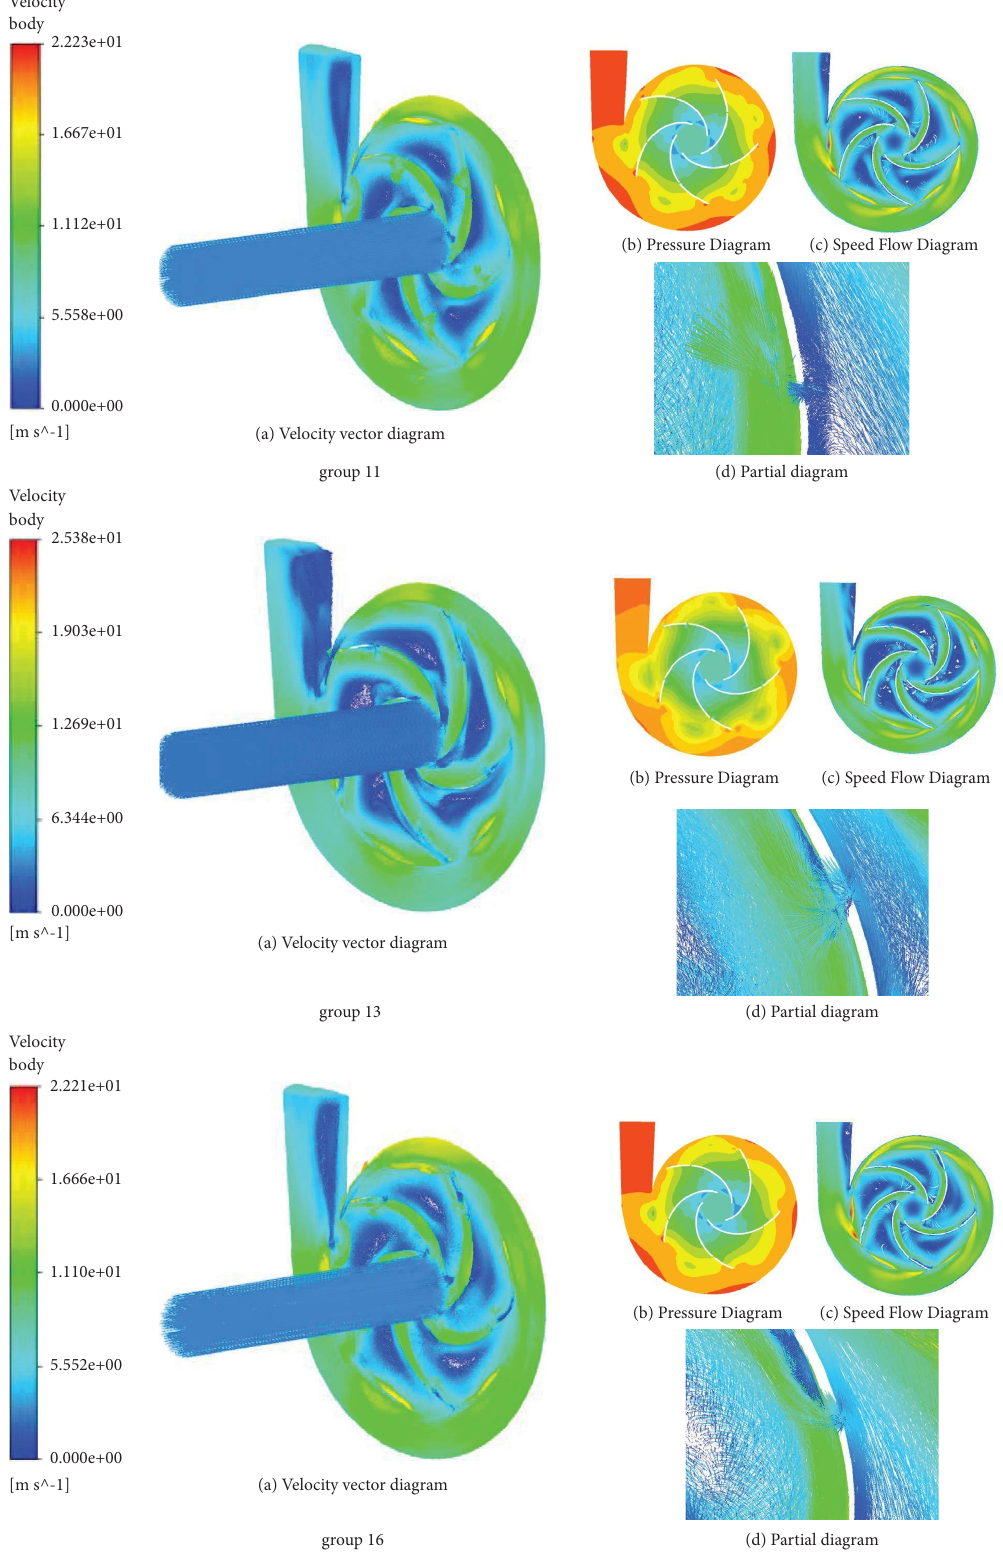
Figure 11: Flow feld diagram of each